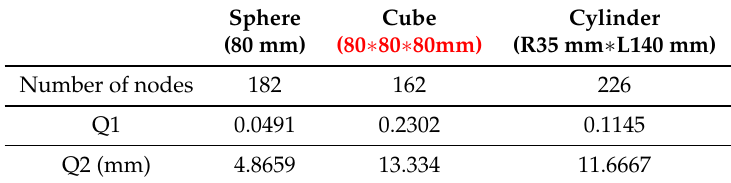
Figure 10. Configuration of the initial grasping points for a sphere, a cube, and a cylinder. Table 1. Evaluation of the initial grasping criteria for a sphere, a cube, and a